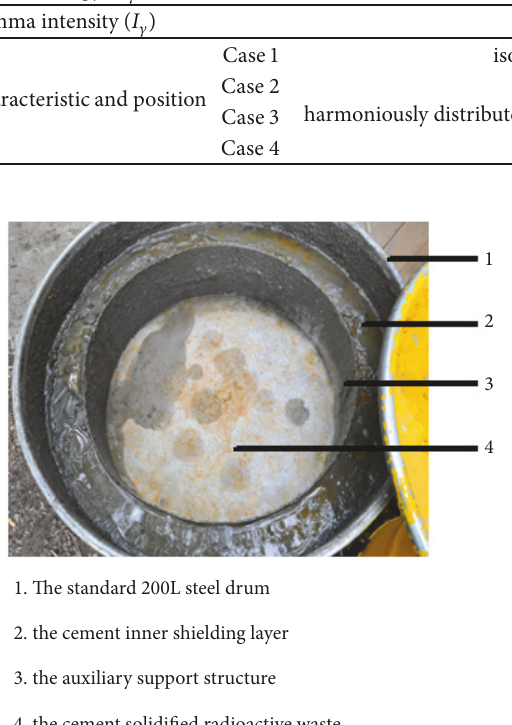
Figure 1: A photo taken from the top of an ILW storage drum.